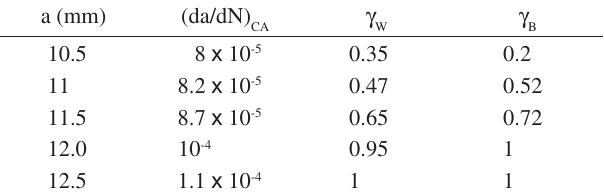
Table 7. Values of the retardation factors g microstructural condition by the Wheeler and Willenborg models, respec- tively.